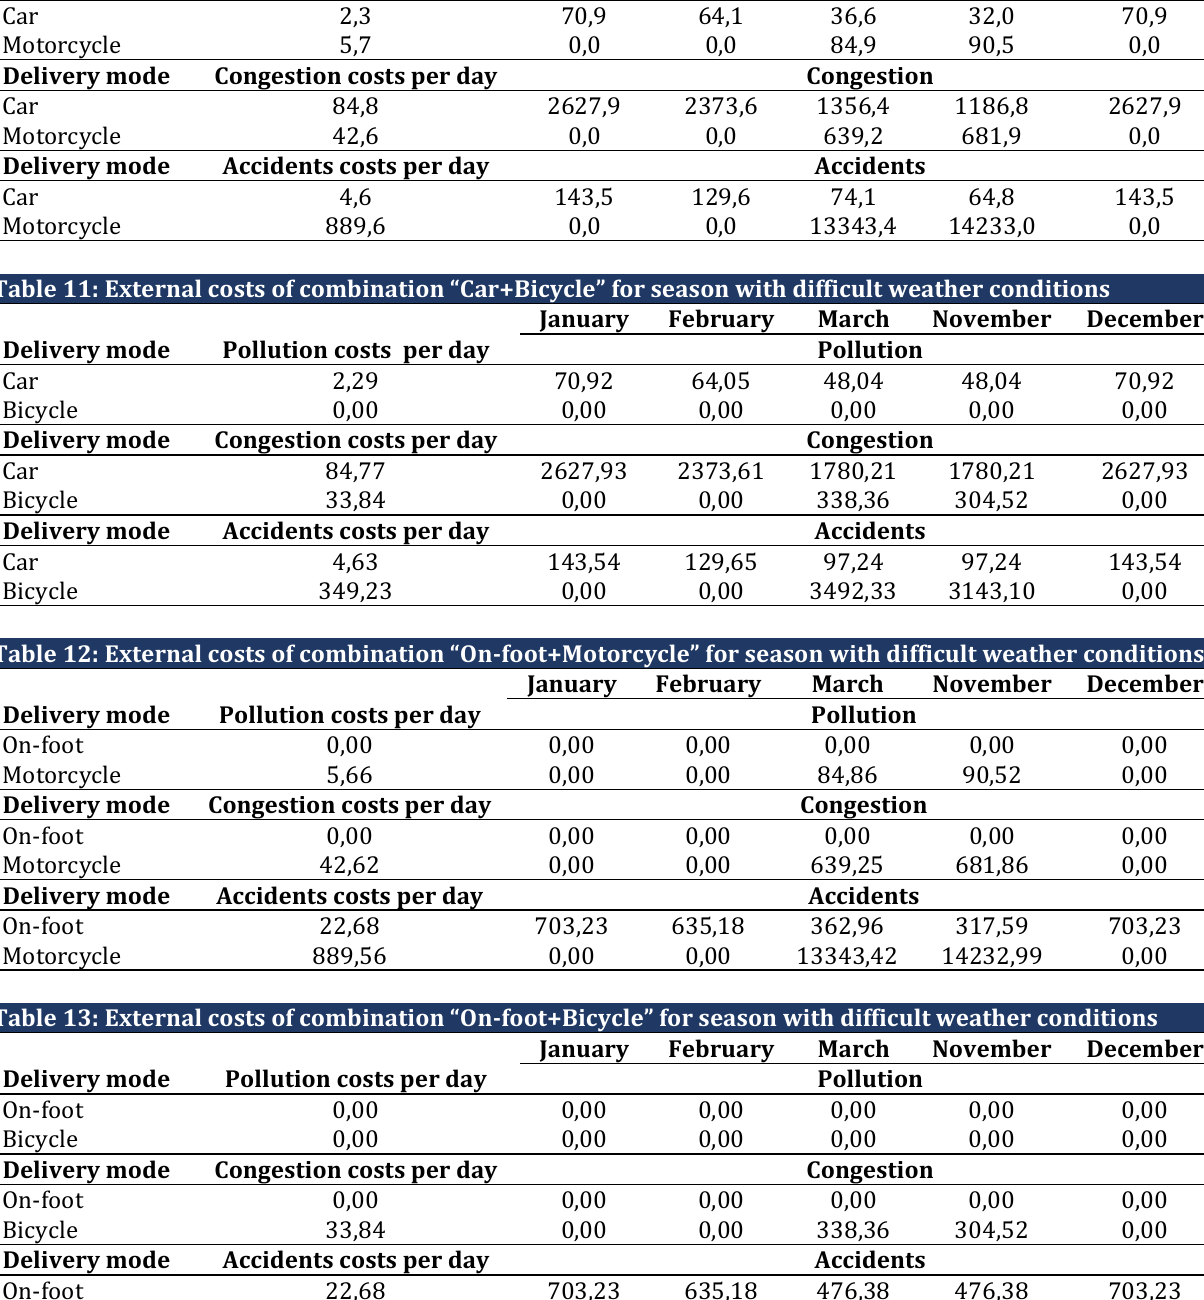
Table 10: External costs of combination “Car+Motorcycle” for season with difficult weather conditions Delivery mode